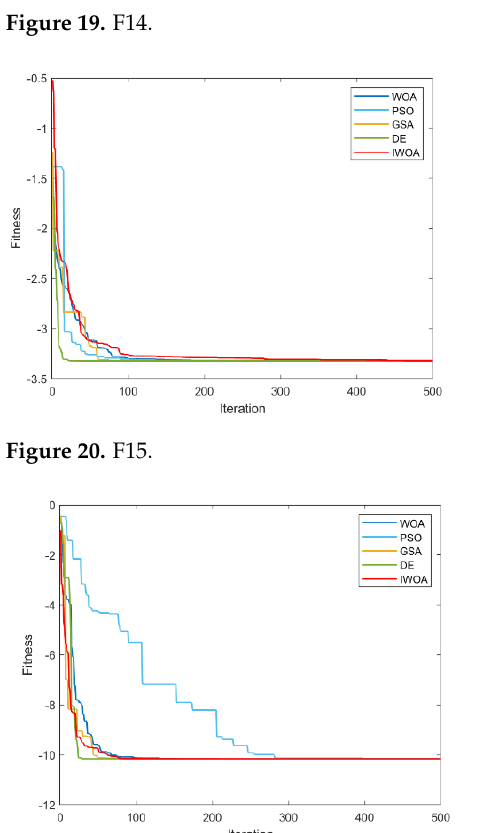
Figure 22. F17. Figure 22. F17.